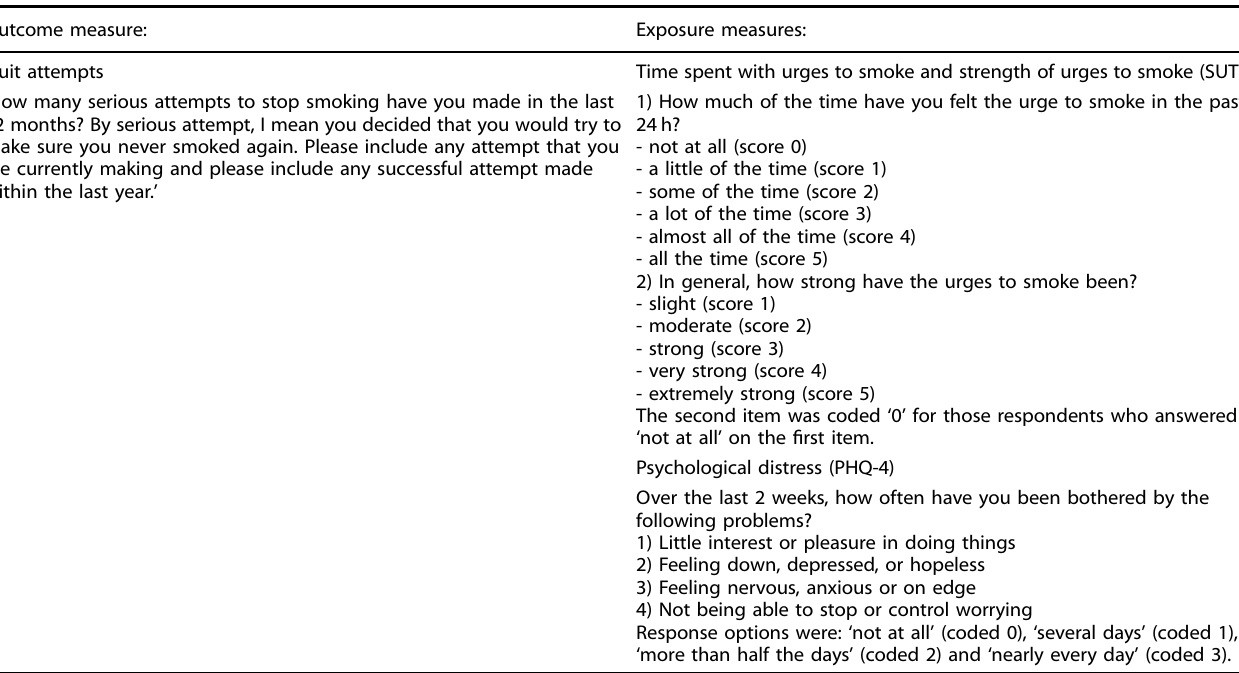
Table 1. Measures used to assess quit attempts, time spent with urges to smoke, the strength of urges to smoke and psychological distress. Outcome measure: Exposure measures: Quit attempts Time spent with urges to smoke and strength of urges to smoke (SUTS) ‘ How many serious attempts to stop smoking have you made in the last 12 months? By serious attempt, I mean you decided that you would try to make sure you never smoked again. Please include any attempt that you are currently making and please include any successful attempt made within the last year.